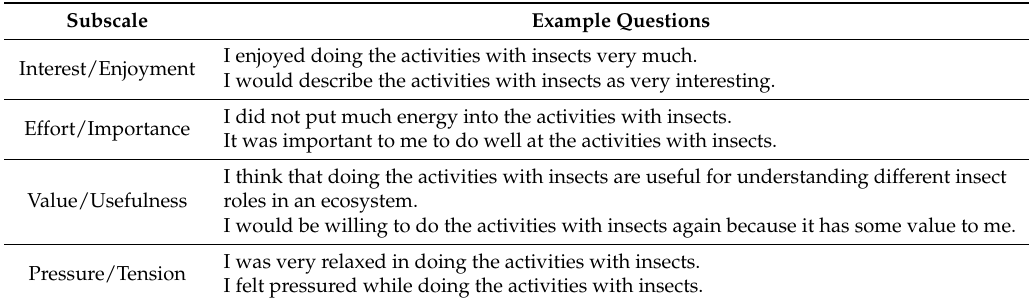
Table 2. Sample questions from the IMI [37], modified to include environmental and entomological